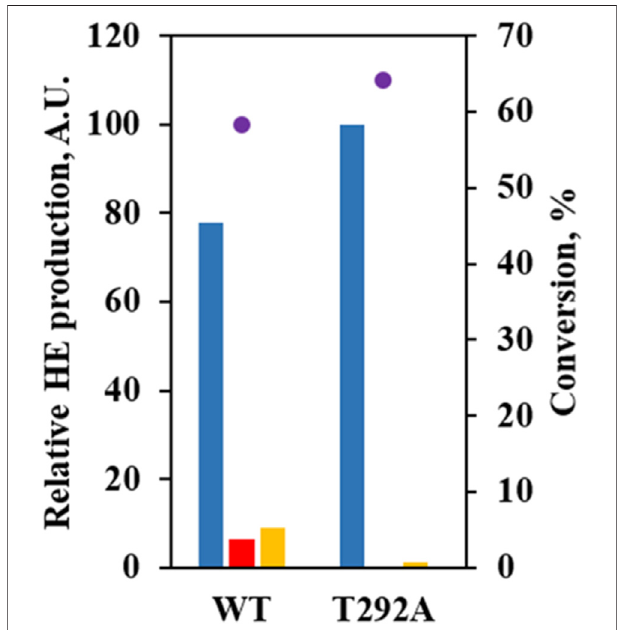
FIGURE 5 | Mutational study to investigate the role of T292 in ( S )-equol hydroxylations. Relative abundances of 6HE (blue bar), 3 ′ HE (red bar), and 6,3 ′ diHE(yellow bar)wereshown with ( S )-equol conversionat 4 h (purple dot) for Ec HpaBC-WT and T292A. The 6HE production level was arbitrarily set to 100, and relative concentrations of the other HEs were estimated with peak areas on gas chromatogram.